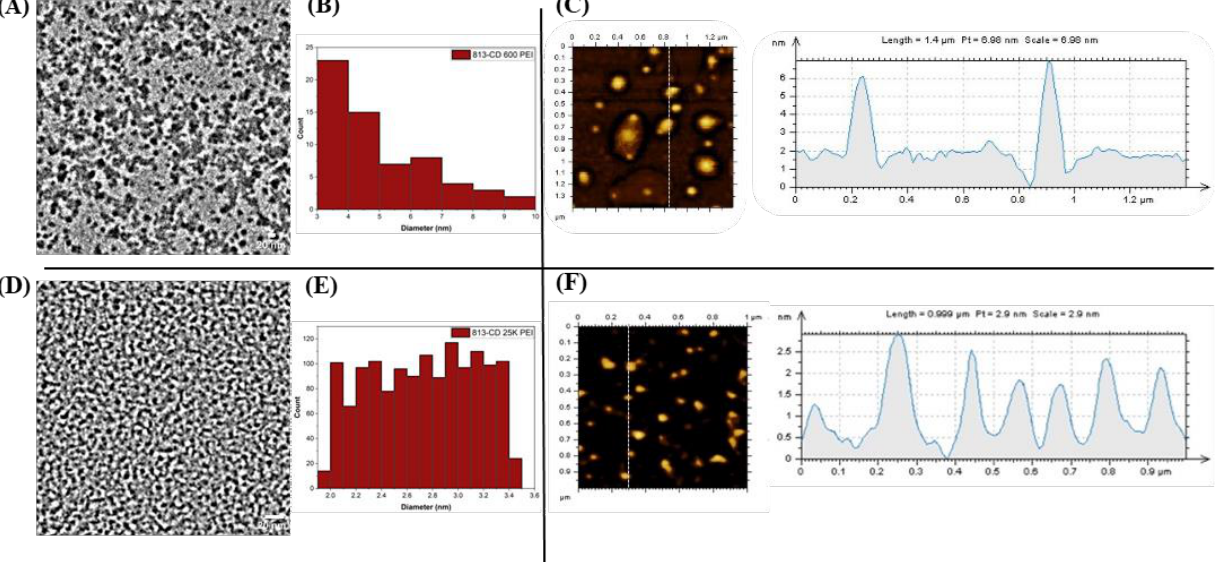
Figure 8. TEM and AFM measurements of 813-CDs. ( A ) TEM of 813-CD-600 PEI. ( B ) AFM scan of 813-CD-600 PEI. ( C ) Histogram of 813-CD-600 PEI. ( D ) TEM of 813-CD-25K PEI. ( E ) AFM measurement of 813-CD-25K PEI. ( F ) Histogram of 813-CD-25K PEI.